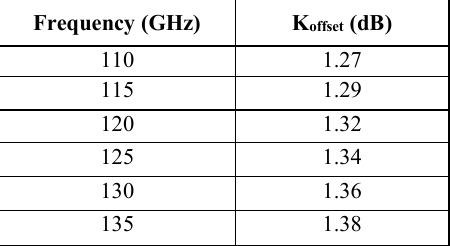
Table 1. Theoretical Coupling loss for Offset